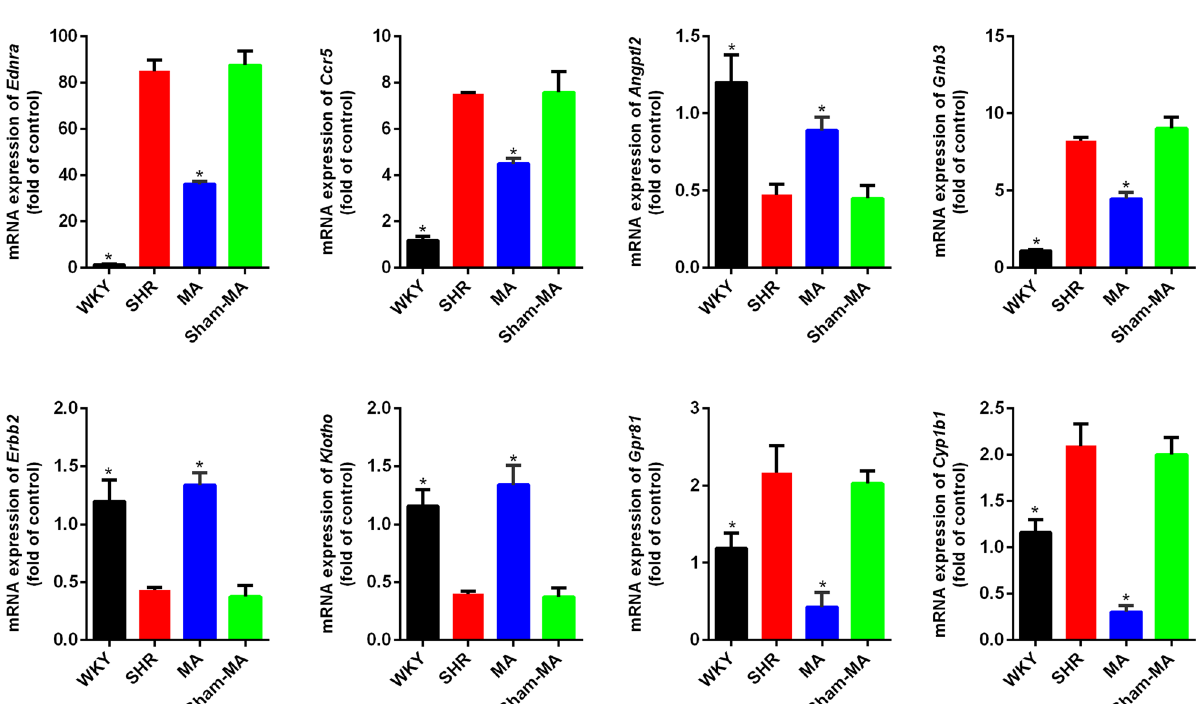
Figure 7. Validation of the up/downregulated genes using qRT-PCR. The loading control gene β-actin was used for normalization. Data are expressed as the mean ± SD. *p < 0.05 versus the SHR group (F (Ednra) = 30.94, F (Ccr5) = 119.78, F (Angptl2) = 74.93, F (Gnb3) = 336.43, F (Erbb2) = 53.47, F (Klotho) = 215.43, F (Gpr81) = 35.09, F (Cyp1b1) = 54.32, one